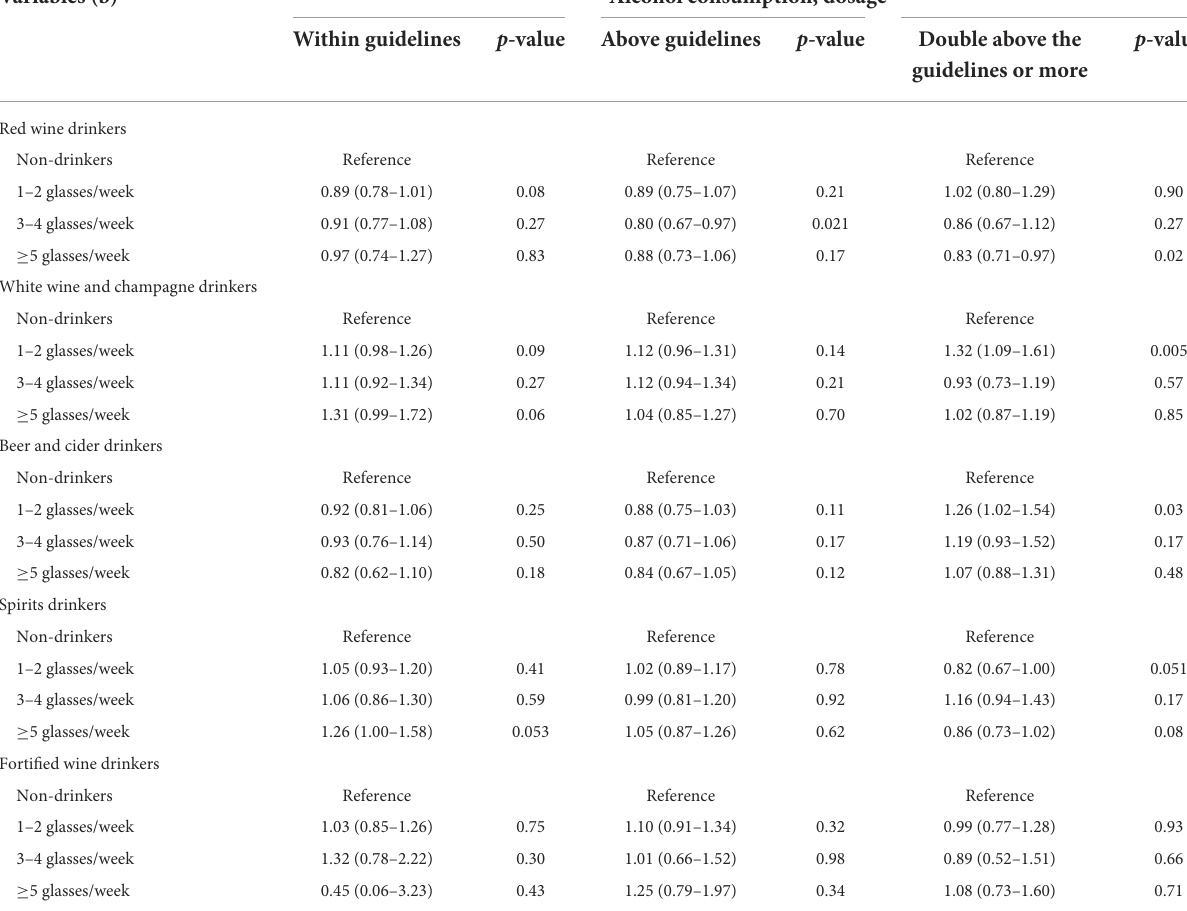
TABLE 5 Odds ratios and 95% CIs for the association between different alcoholic beverages and IBD risk, separated by the amount of alcohol consumption. Variables (b)